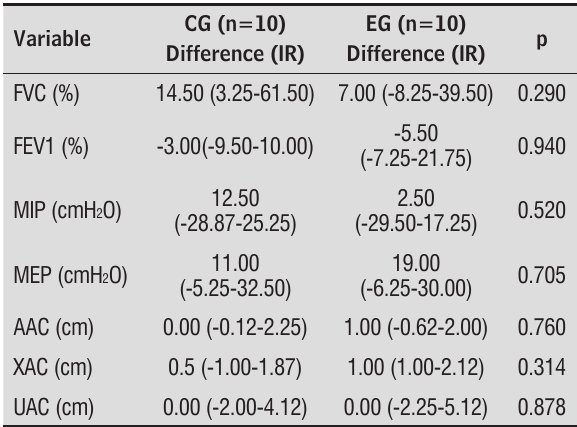
Table 3 - Comparison of respiratory parameters between groups, before and after interventions (p-values refer to Man-Whitney test). Salvador, Bahia, Brazil,